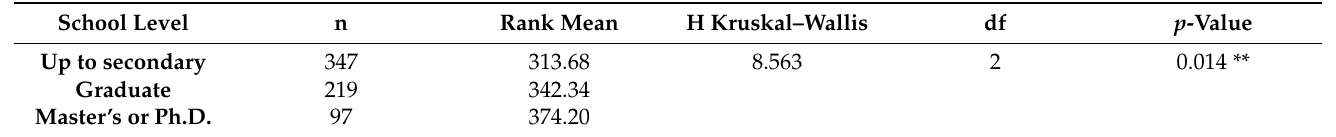
Table 4. Results of the Kruskal–Wallis test to compare consumers’ attention to companies’ green marketing communication, exploring education level.